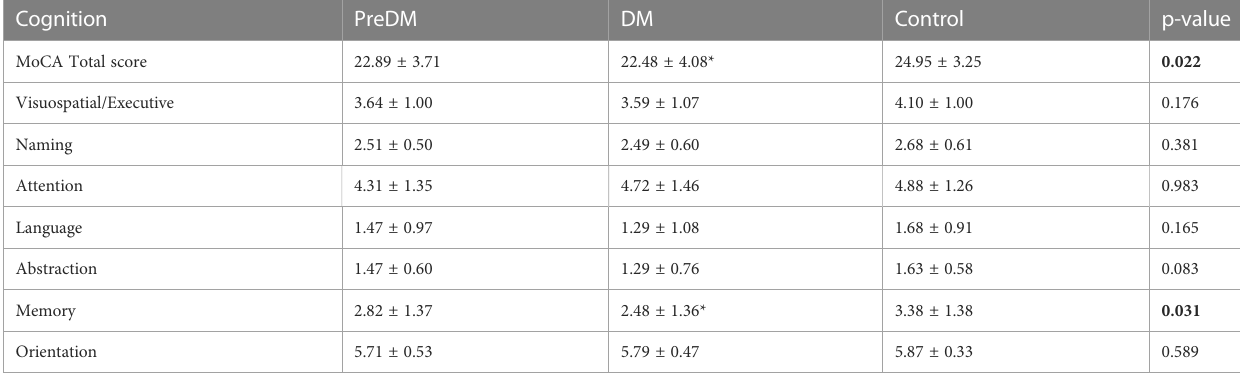
TABLE 2 Comparison of total score and subscores of MOCA between patients with prediabetes, diabetes and healthy controls.